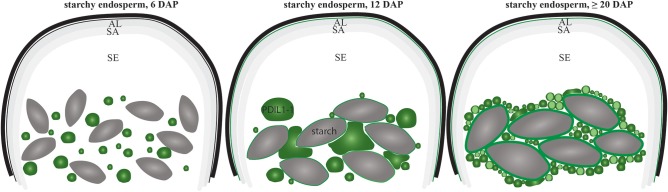
Schematic overview of the re-localization of HvPDIL1-1-positive PBs during starchy endosperm development. Note the decrease of the diameter of the HvPDIL1-1 labeled PBs (green) between 6 DAP and ≥20 DAP (summarizing Figure 7, Figures S4, S8). First fusing events with the protein matrix at the periphery of starch granules (gray structures) was observed at 12 DAP and continued at ≥20 DAP. AL, aleurone; SA, subaleurone; SE, starchy endosperm; Note the indicated starch granules. The localization of HvPDIL1-1 at the plasma membrane in the SE at 12 and ≥20 DAP is indicated as the plasma membrane is green colored (summarizing Figures 7, 9B).